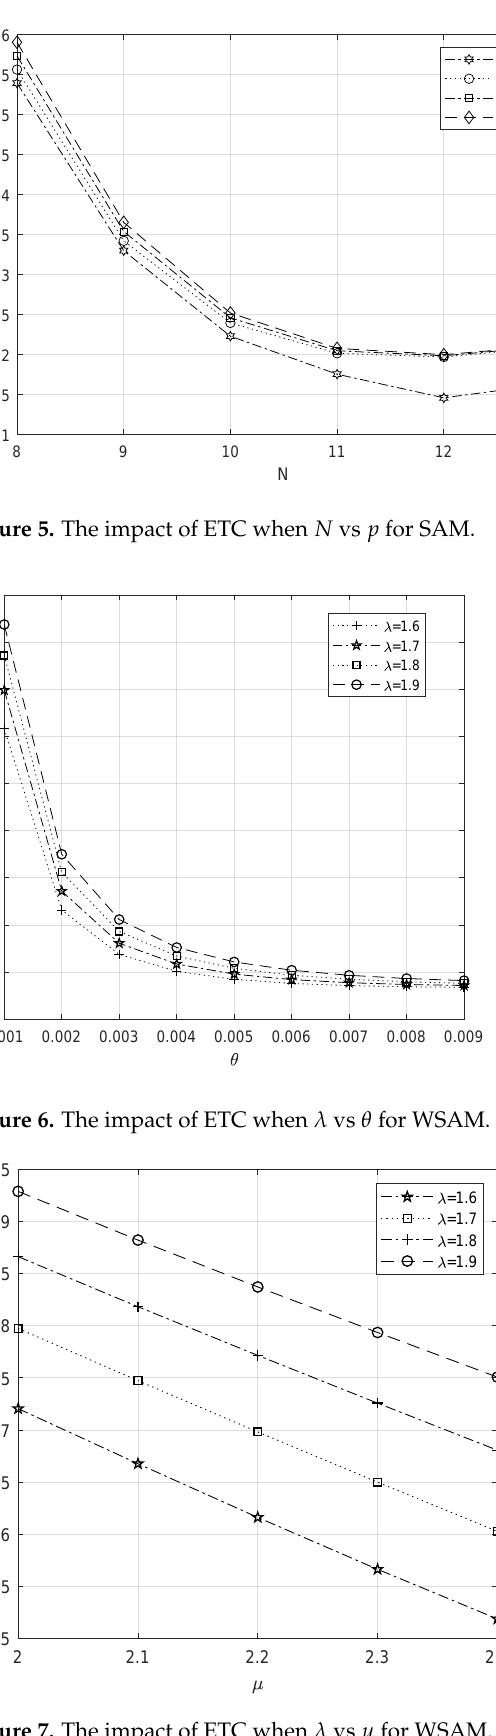
Figure 7. The impact of ETC when λ vs µ for